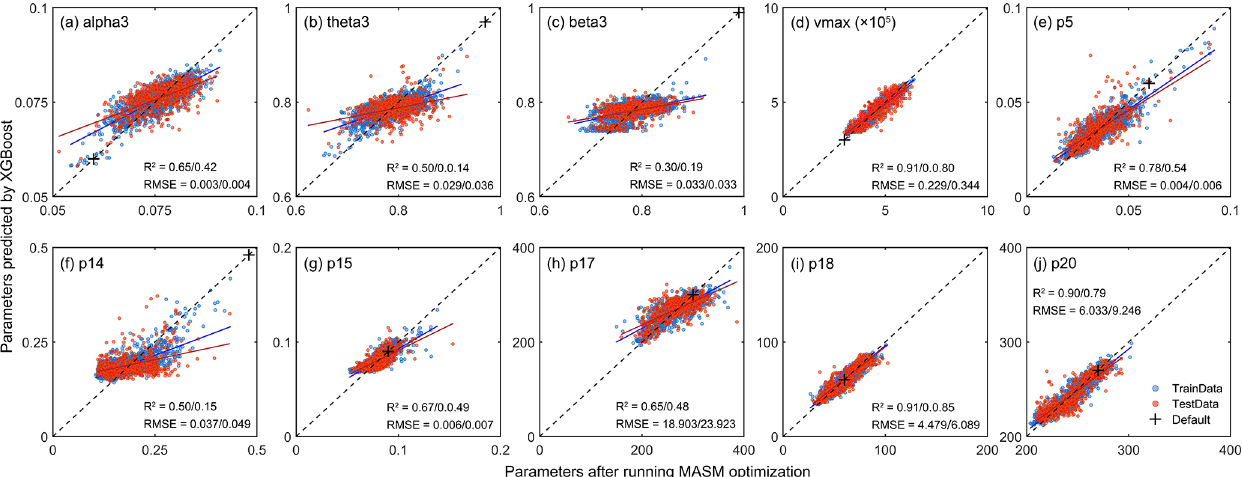
Figure 5. Scatter plots of the results of the XGBoost model. The x axis represents parameters after running MASM optimization and y axis means values obtained from XGBoost model. The means before and after the slash represent the accuracy indexes of the training set and testing sets, respectively. The blue dots represent the training set and red dots represent the testing set. The black cross indicates default values.